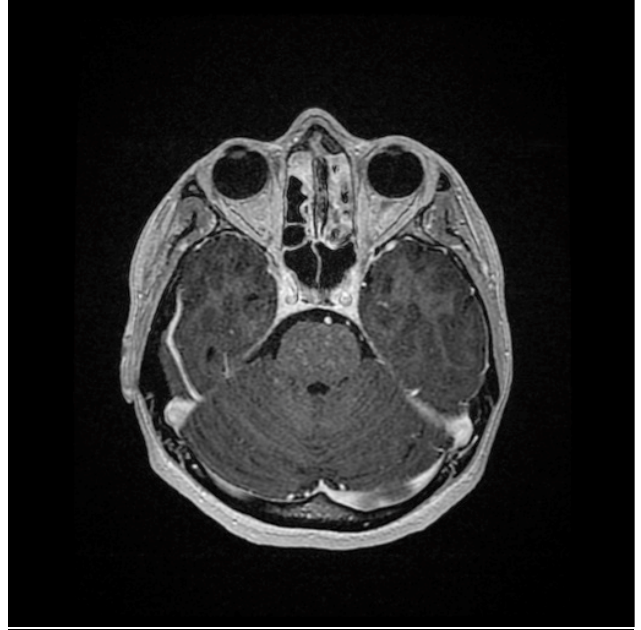
Figure 1. Brain magnetic resonance imaging (MRI) of a patient with CLIPPERS (coronar post-contrast T1-weighted images). MRI shows foci of gadolinium enhancement with a punctate and curvilinear pattern predominantly in the pons. Medicina 2023 , 59 , x FOR PEER REVIEW